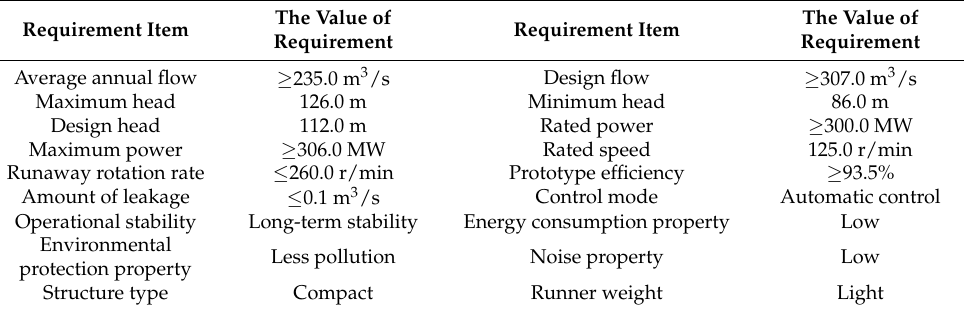
Table 1. The Design and Exploitation Requirement Parameters of a Hydropower Station.